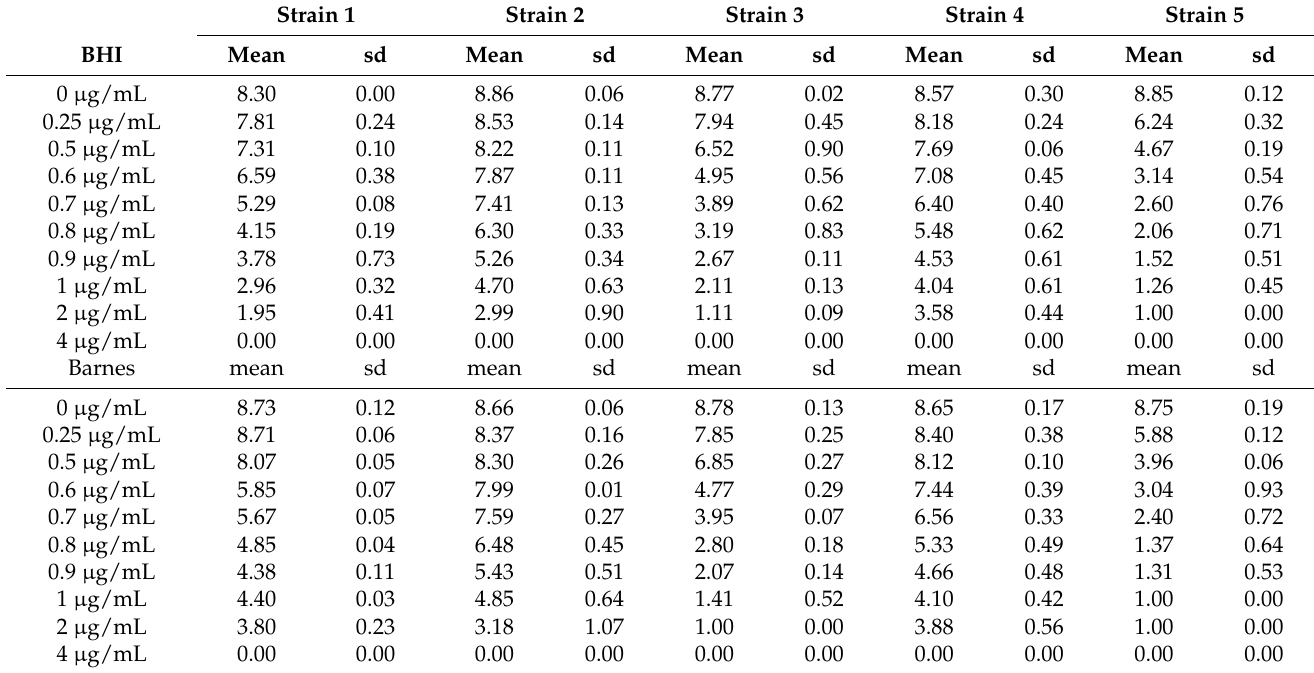
Table 1. Results of the inoculum on BHI and Barnes agar, log CFU mL − 1 and standard deviation (sd), n =